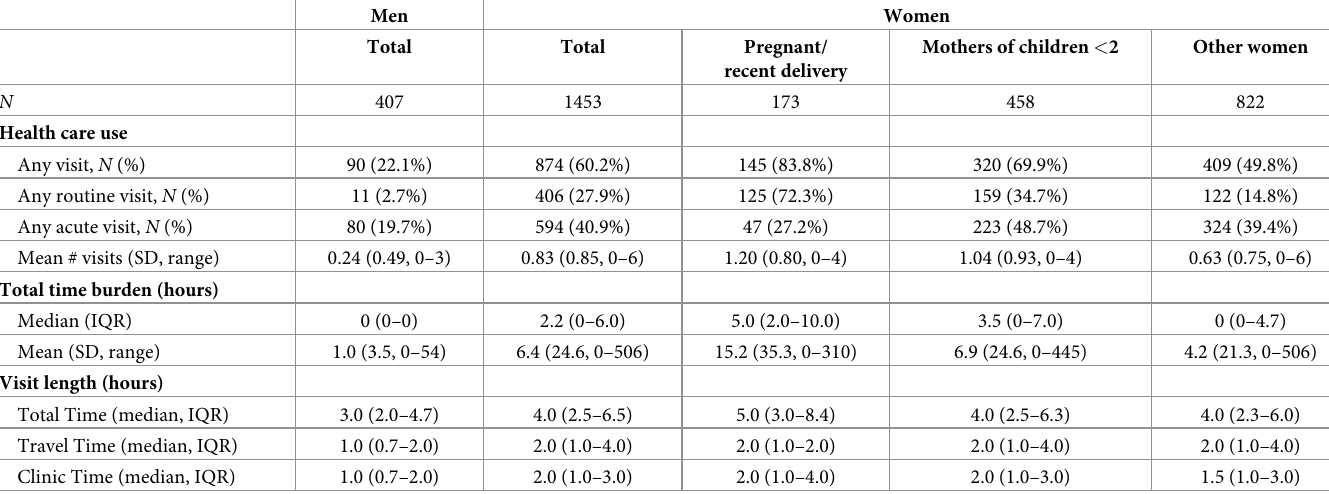
Table 3. Health service use over a 2-month period and associated time by subpopulation, TLT 2015.